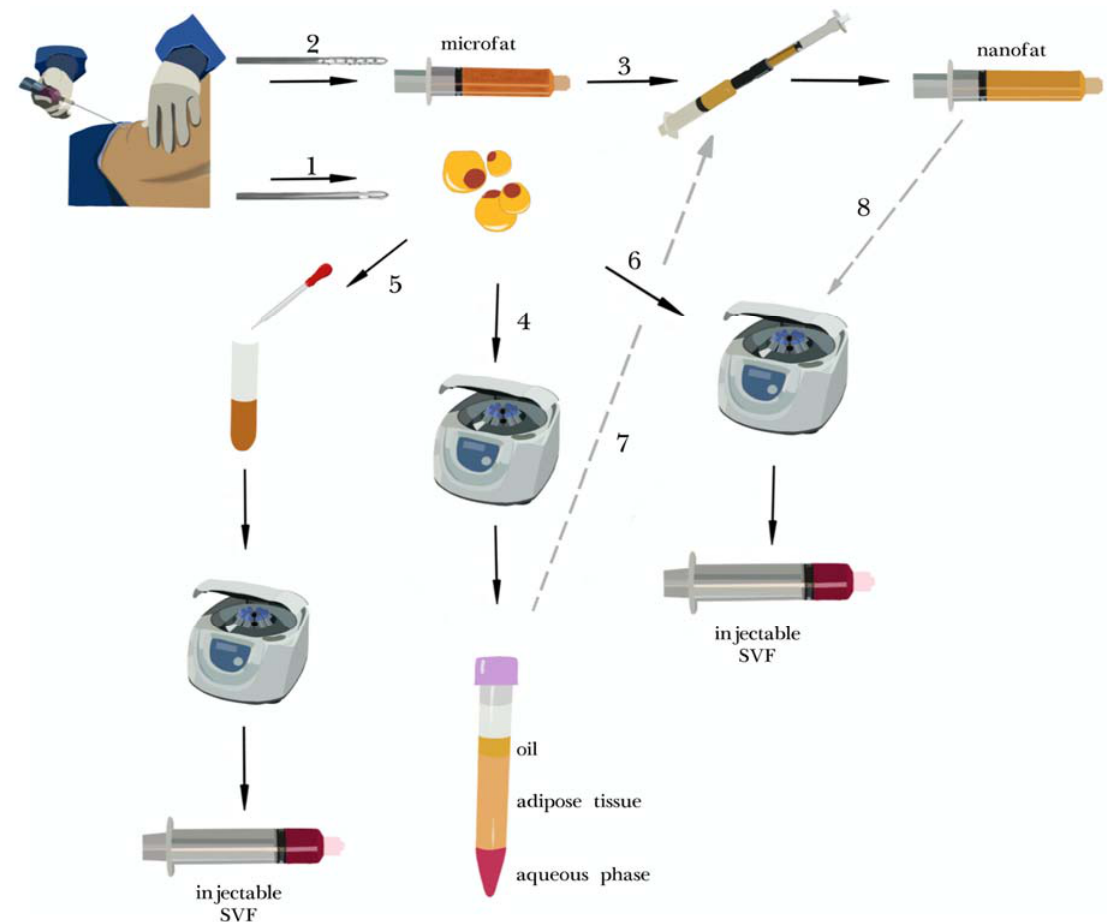
Figure 2. Overview of fat processing and stromal vascular fraction (SVF) isolation techniques. Liposuction can be performed either with a classic cannula ( 1 ) for normal fat harvesting or with a multi-perforated cannula ( 2 ), which results in obtaining microfat. If microfat is subsequently processed 30 times between two Luer-Lock syringes ( 3 ), the emulsified product is called nanofat. Centrifugation ( 4 ) is used to condensate fatty tissue (most commonly with Coleman’s protocol at 3000 RPM for 3 min) [69]. The stromal vascular fraction (SVF) may be obtained by enzymatic isolation ( 5 ) with the use of collagenase and subsequent centrifugation. Alternatively, mechanical isolation may be used ( 6 ) usually it comprises several steps of mechanical dissociation of fatty tissue with centrifugation, filtration etc. Some researchers combine prior centrifugation with mechanical emulsification, thus producing more condensed nanofat ( 7 ). Another modification may be additional centrifugation after nanofat production ( 8 ).